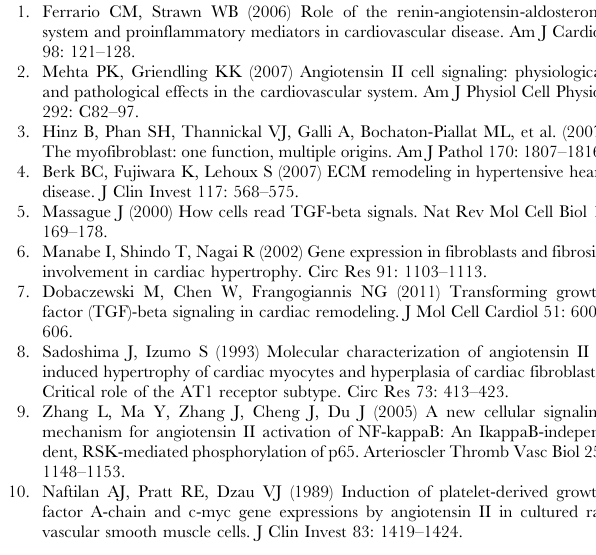
Figure S3 Col1 a 1, Col1 a 2 or Col3 a 1 mRNA levels in siRNA transfected cardiac fibroblasts. mRNA levels were assessed by quantitative real-time PCR (qPCR) after Ang II treatment for 0, 6 and 12 hrs and normalized to b -Tubulin (n= 3). Data are the mean 6 SEM. *P , 0.05, **P , 0.01 vs. scrambled siRNA. (TIF) Figure S4 TGF- b 1 protein levels in cardiac fibroblasts infected with different titers of Ad-Klf4 and Ad-tTA in the presence or absence of tetracycline (0.1 m g/ml). After infection 24 hrs, TGF- b 1 protein levels were assessed by Western blot and showed a titer-dependent increase. (TIF) Figure S5 a -SMA, Col1 a 1, Col1 a 2 and Col3 a 1 mRNA levels in cardiac fibroblasts infected with Ad-Cre for Klf4 deletion or reintroduced Klf4 expression. mRNA levels were assessed by quantitative real-time PCR (qPCR) after Ang II treatment for 0 and 6 hrs and were normalized to b - tubulin. Panel 1 for Ad-Cre-infected WT cardiac fibroblasts; Panel 2, Ad-Cre-infected Klf4-floxed cardiac fibroblasts; Panel 3, Ad- Cre infected without Klf4 reintroduction; Panel 4, Ad-Cre infected with Klf4 reintroduction (n = 3). Data are the mean 6